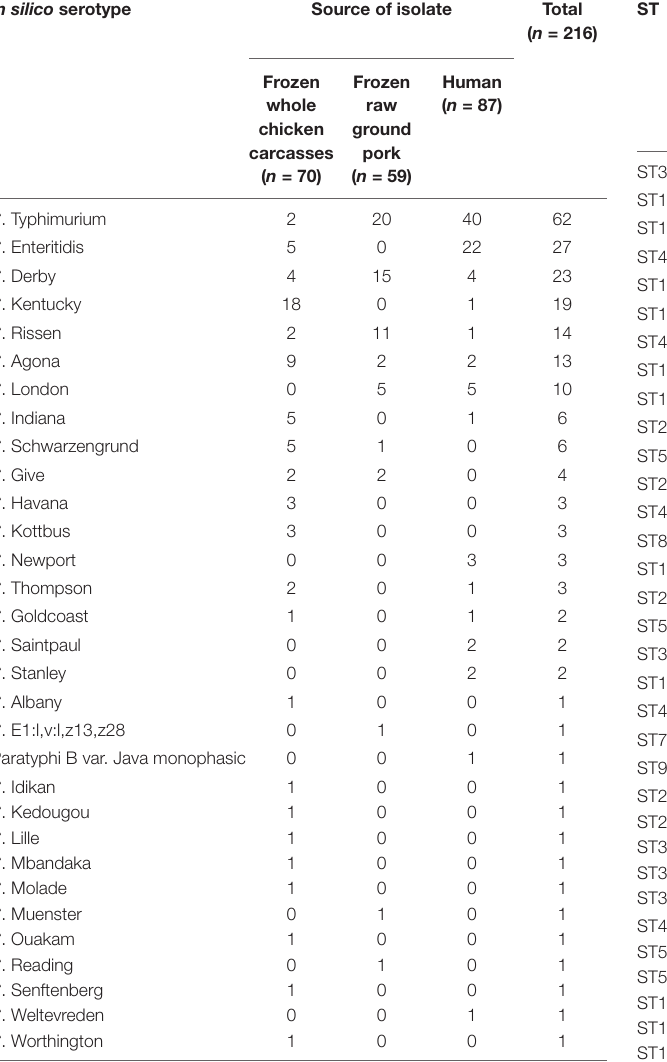
TABLE 4 | Distribution of Salmonella isolates of Sequence Typing (ST).